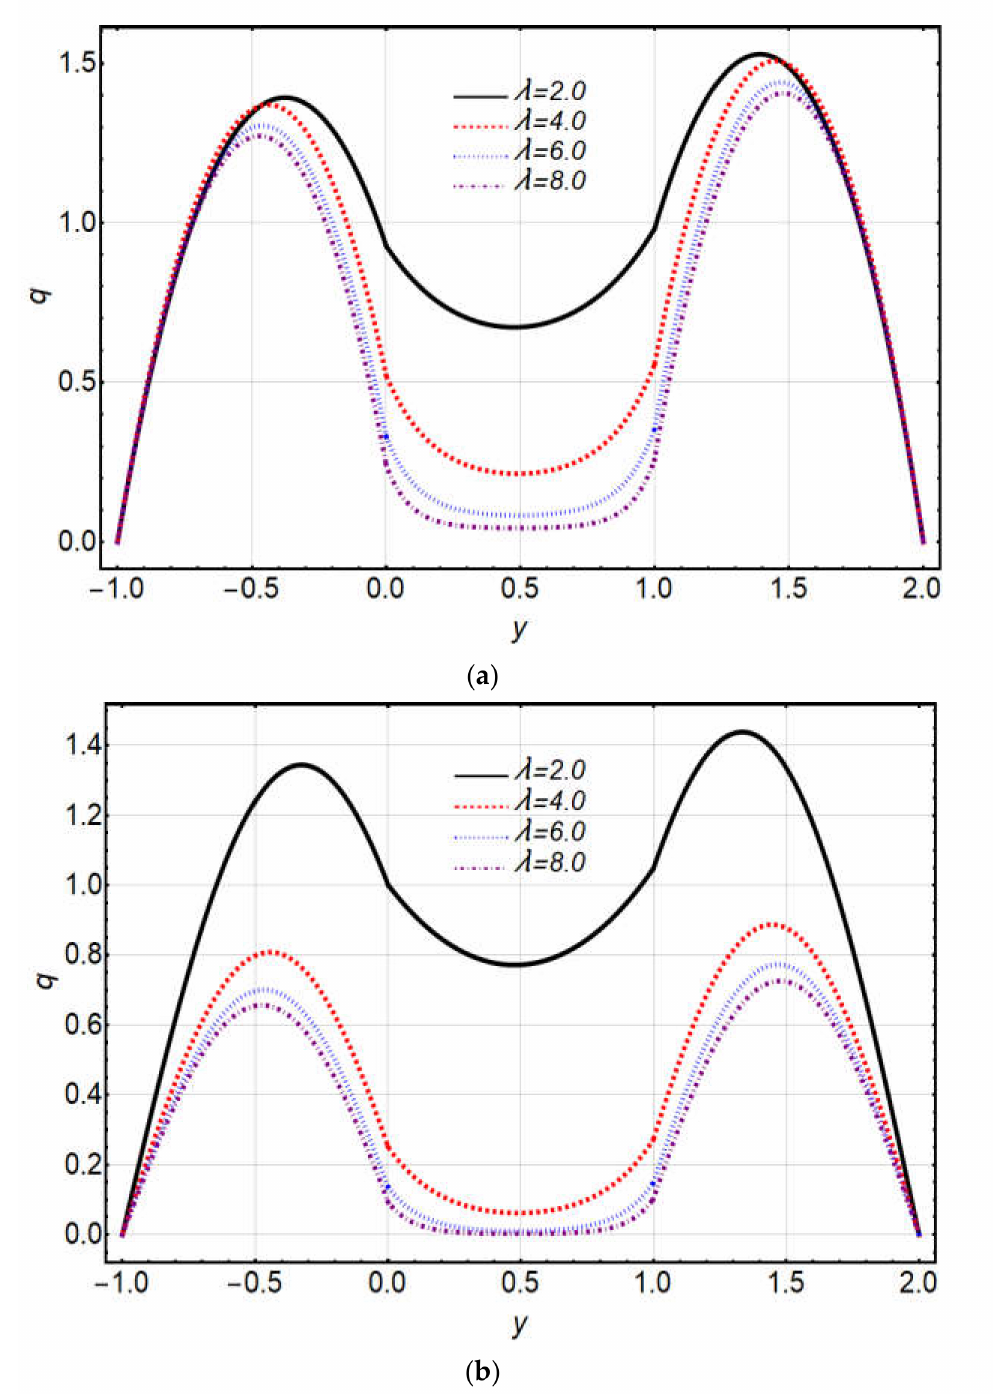
Figure 2. Velocity distribution against λ : ( a ) axial, ( b )